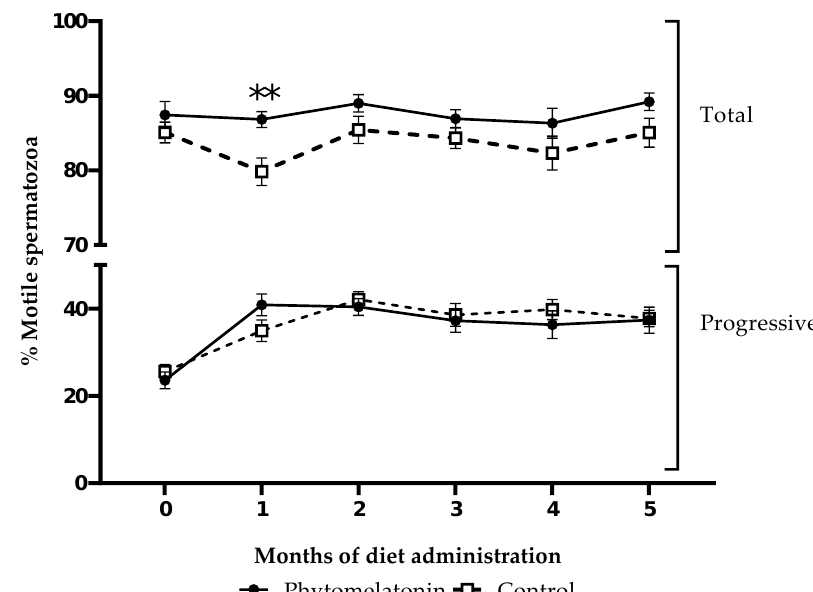
Figure 3. Percentage of total motile (top) and progressive (bottom) spermatozoa in semen samples from animals fed with a phytomelatonin- rich (●) or commercial (control, □) diet from month 0 (before diet administration) to month 5. Values are shown as mean ± S.E.M., n = 16. ** p < 0.01 indicates significant differences between the two experimental groups.